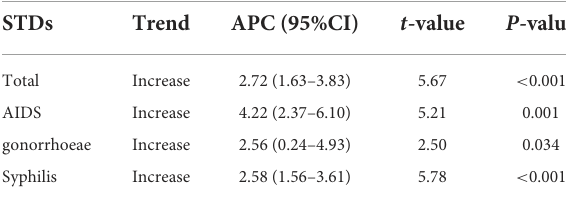
TABLE 1 Trends in the incidence of STDs from 2011 to